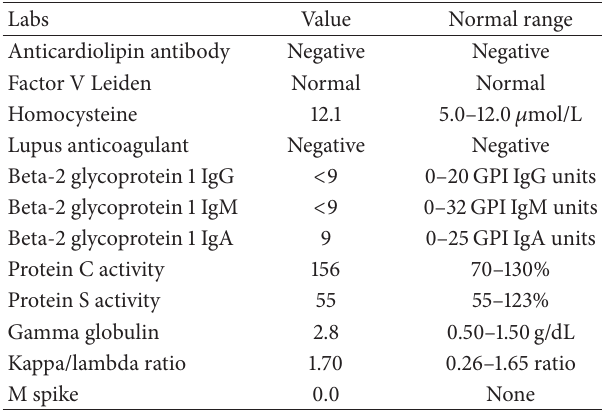
Table 2: Hypercoagulable laboratory